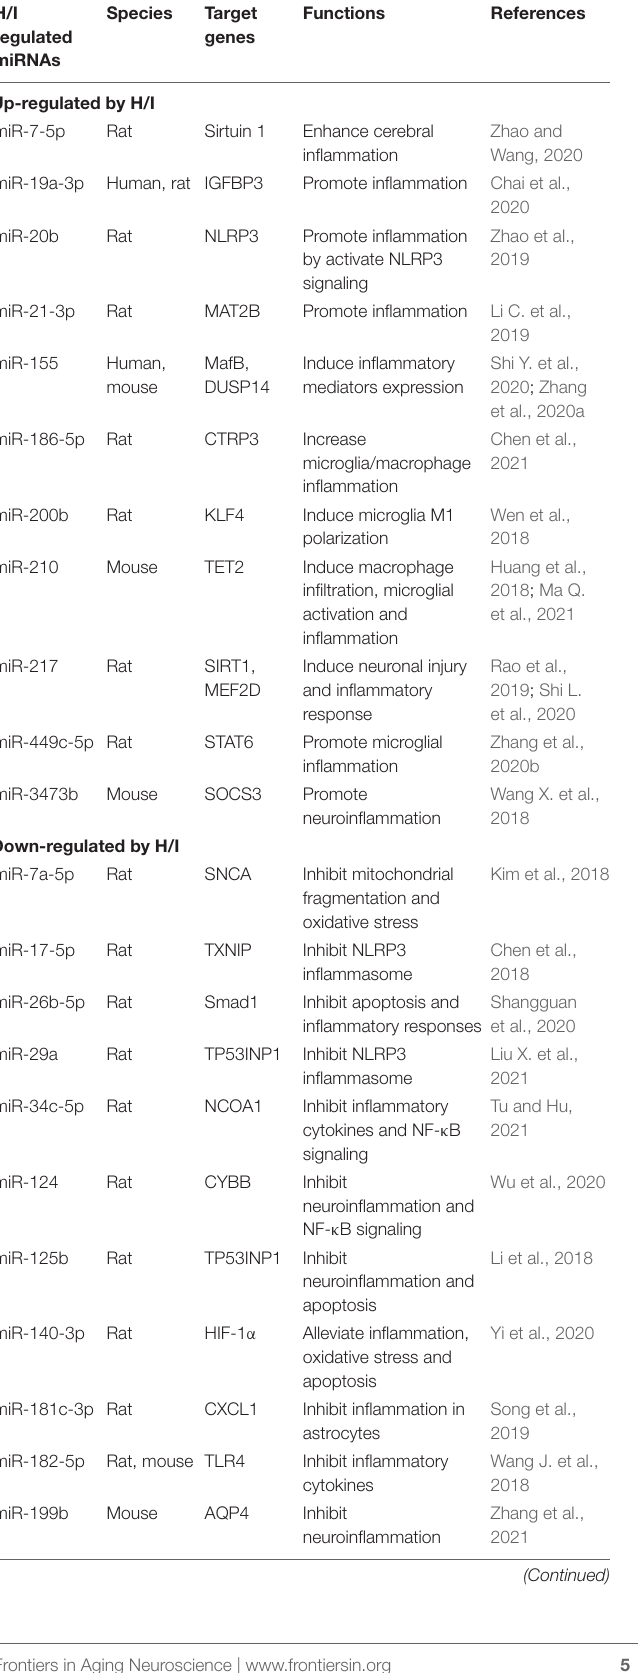
TABLE 3 | H/I-induced changes of miRNAs in the brain with defined target